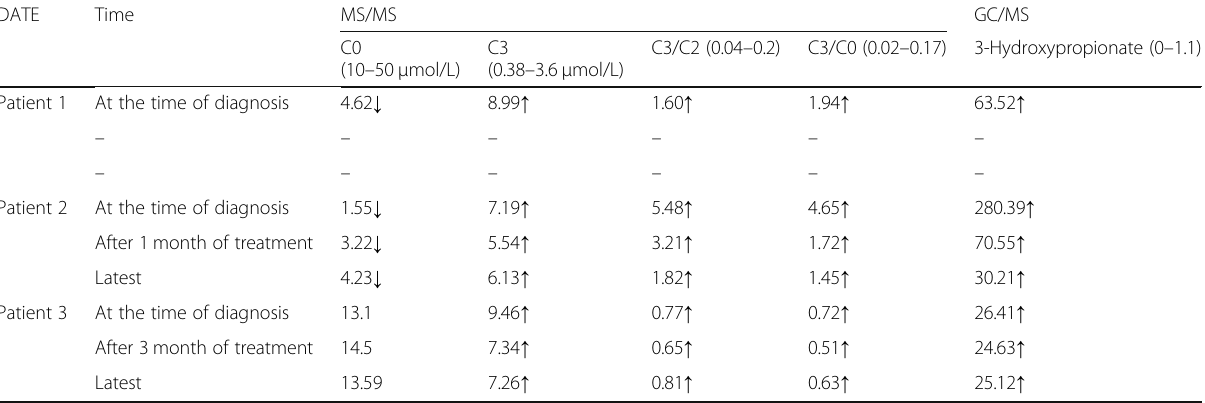
Table 1 The results of MS/MS and GC/MS in neonatal